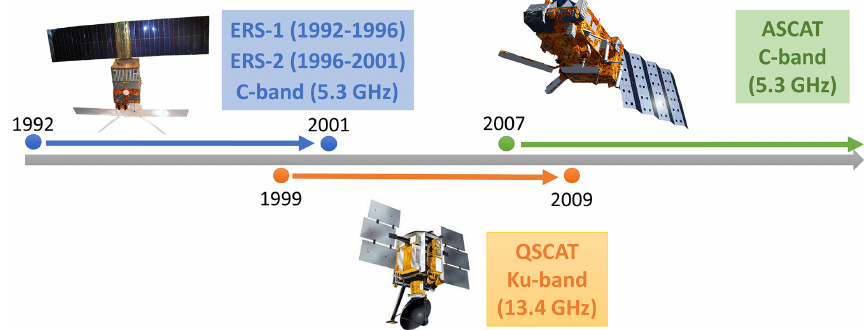
Figure 1. Temporal coverages and radio frequencies of ERS-1/-2, QSCAT, and ASCAT. ERS-1/-2 and ASCAT have a C-band radio frequency (5.3GHz), and QSCAT has a Ku-band frequency (13.4GHz). QSCAT operated between 1999 and 2009 in full mode, overlapping with both ERS and ASCAT. Image courtesy of NASA and the European Space Agency